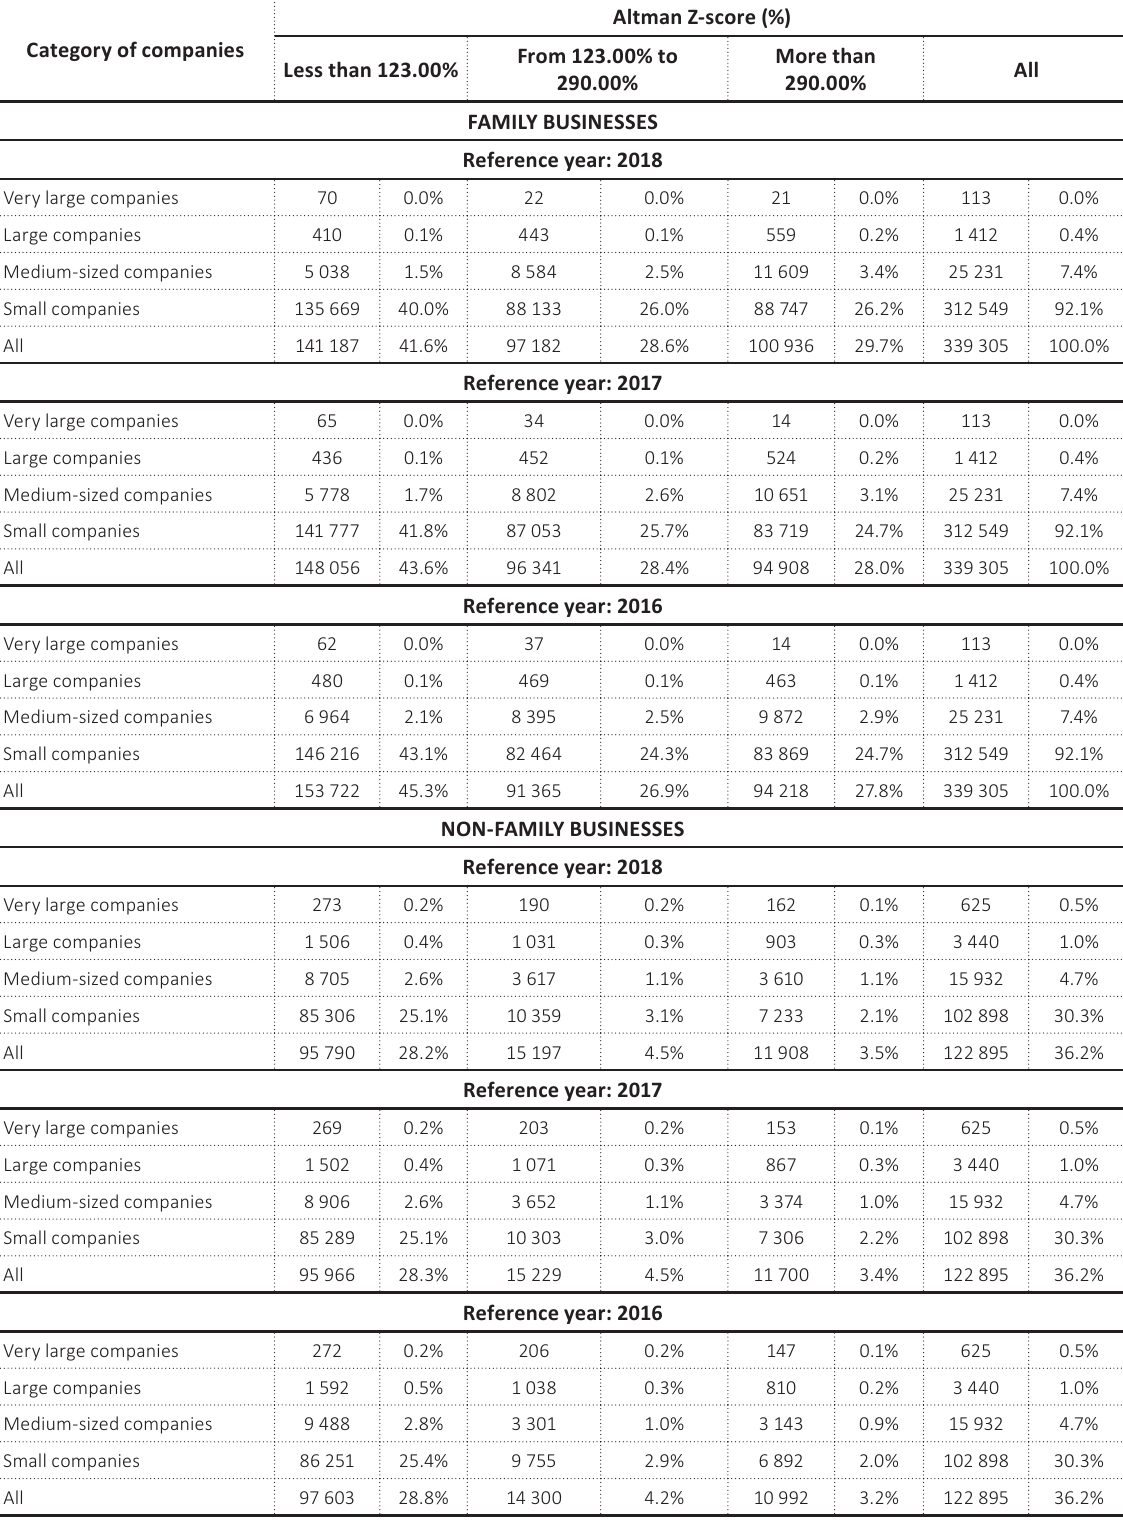
Table 2. Altman Z-scores of the total of active Hungarian companies grouped by size and differentiated by